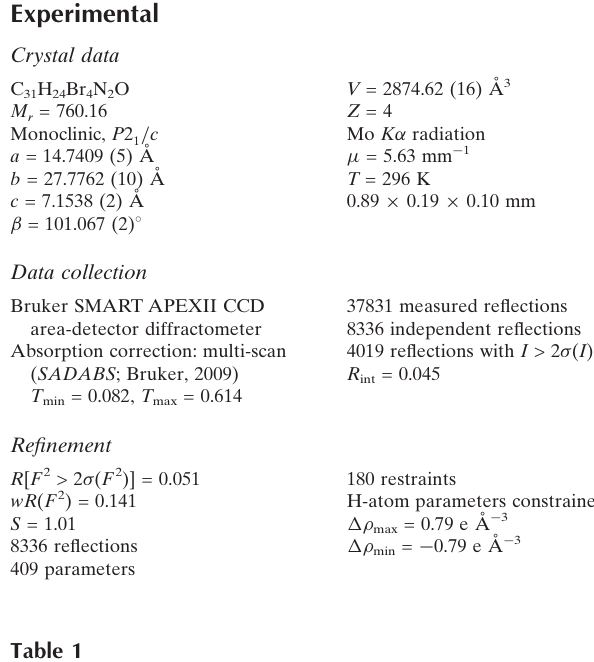
Hydrogen-bond geometry (A˚ , (cid:3)